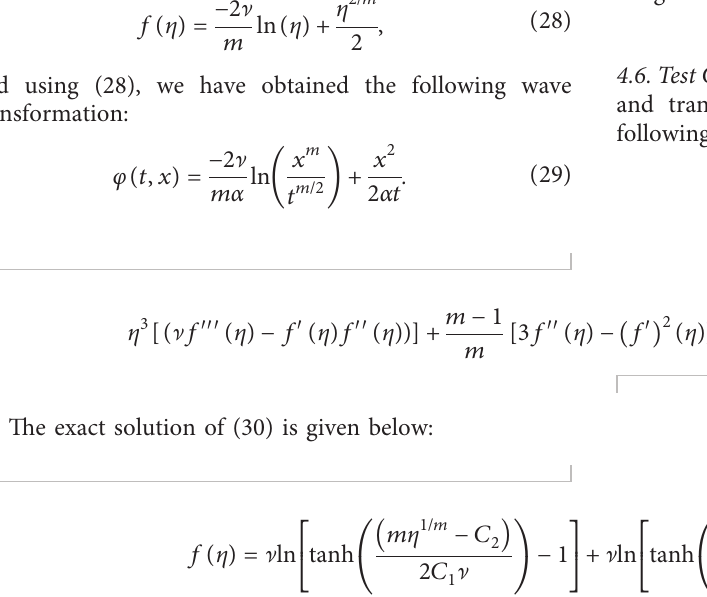
Figure 5: Plot of solution U